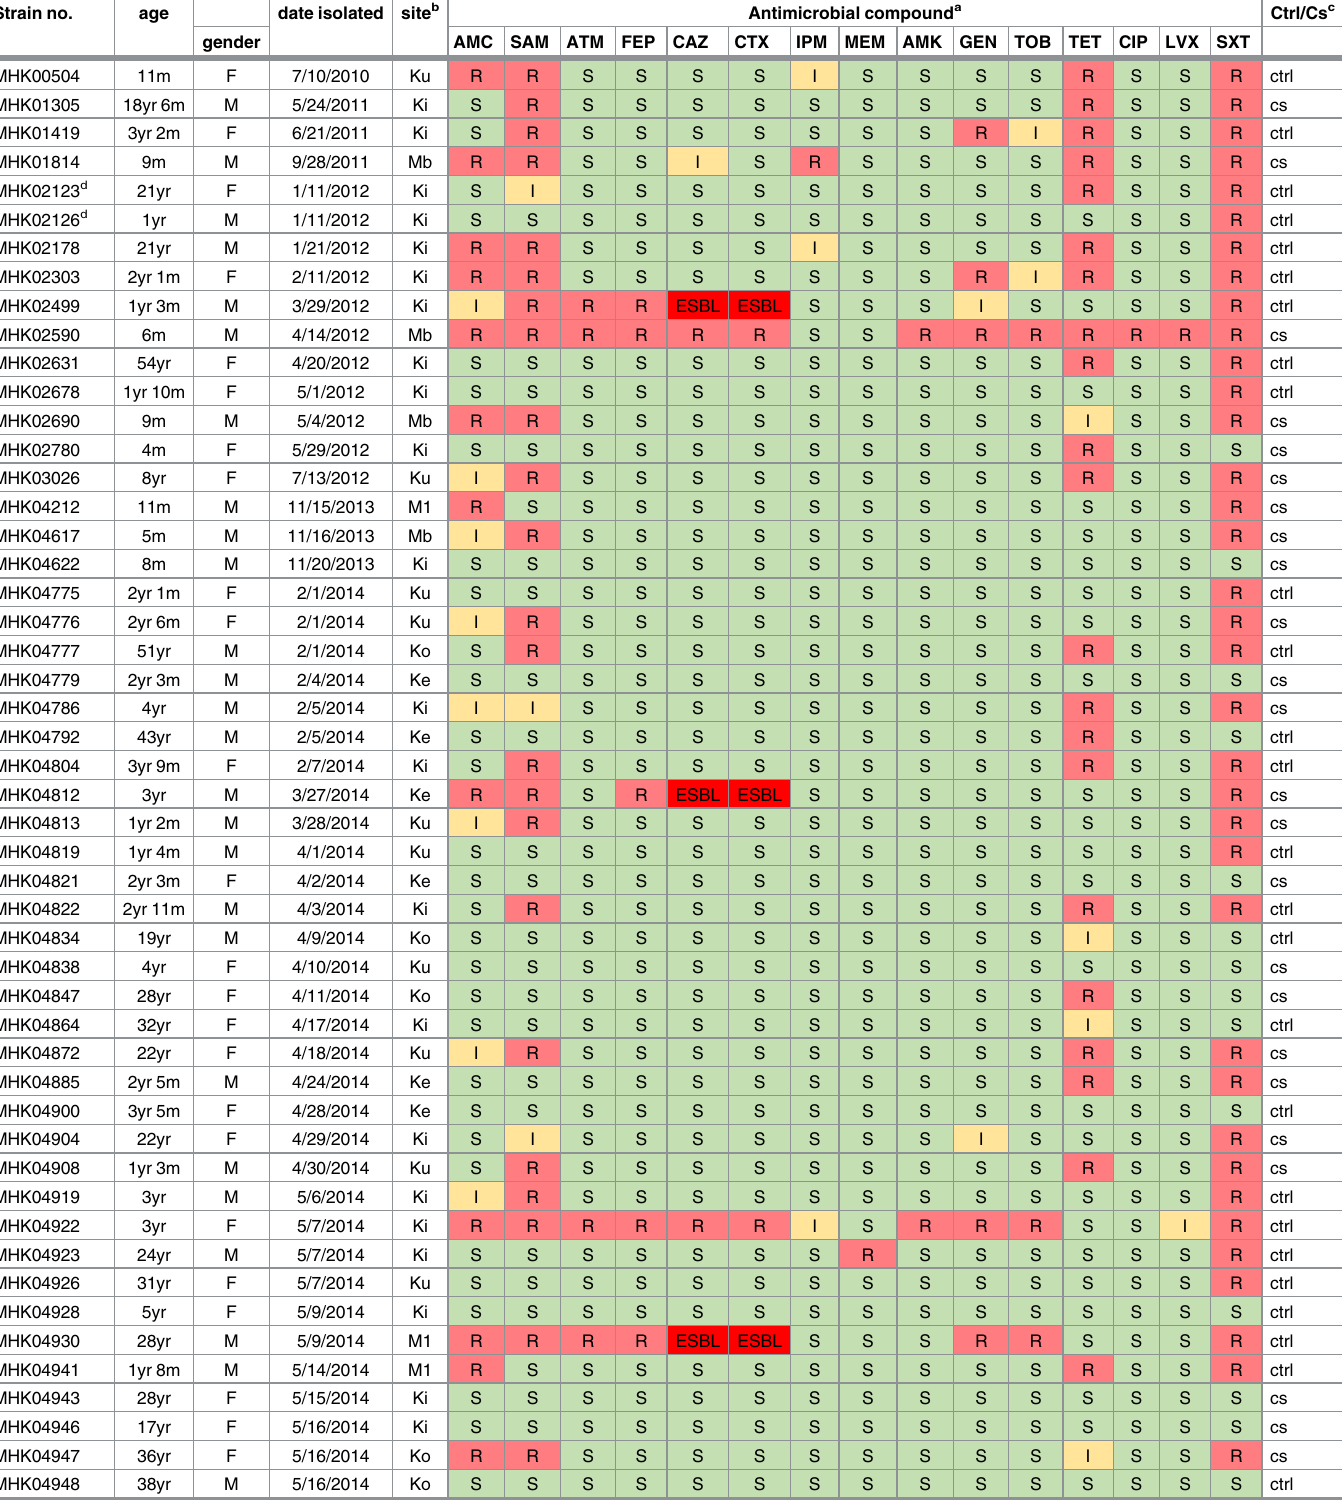
Table 2. Metadata and phenotypic antimicrobial susceptibility for individual isolates. Strain